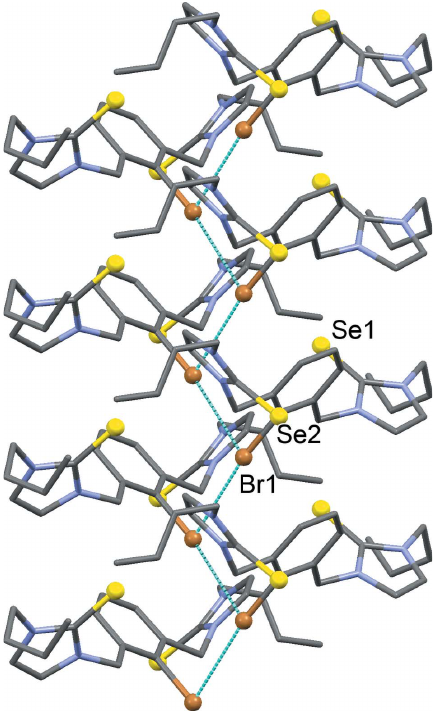
Figure 2 Diagram showing the Br (cid:2)(cid:2)(cid:2) Br intermolecular interactions (as dashed lines), linking the molecules into zigzag chains propagating along the b axis direction. For the disordered n -butyl substituent only the major component is shown, and H atoms have been omitted for clarity.